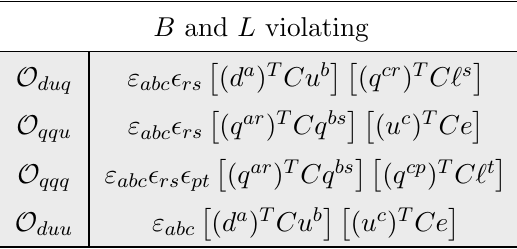
Table 4 . Baryon and lepton number violating four-fermion operators. All operators are included in Warsaw basis. Fermion family indices are omitted. Indices r; s; p; t; : : : and a; b; c; : : : denote the SU(2) L and SU(3) c fundamental representations, respectively. C is the Dirac charge conjugation